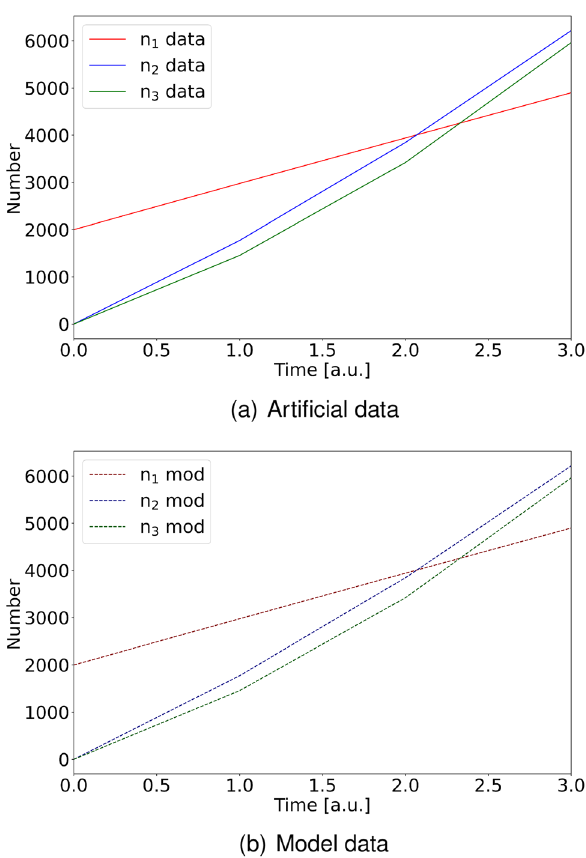
Figure 2. The figure shows the generated artificial data ( a ) using µ/σ = 0.1 / 0.1 compared to the model data ( b ) over time in case that j i were not provided during optimization. As can be seen from Table 5, this case had the largest difference between artificial data and model. However, even in this case the curves representing data and model cannot be distinguished by direct